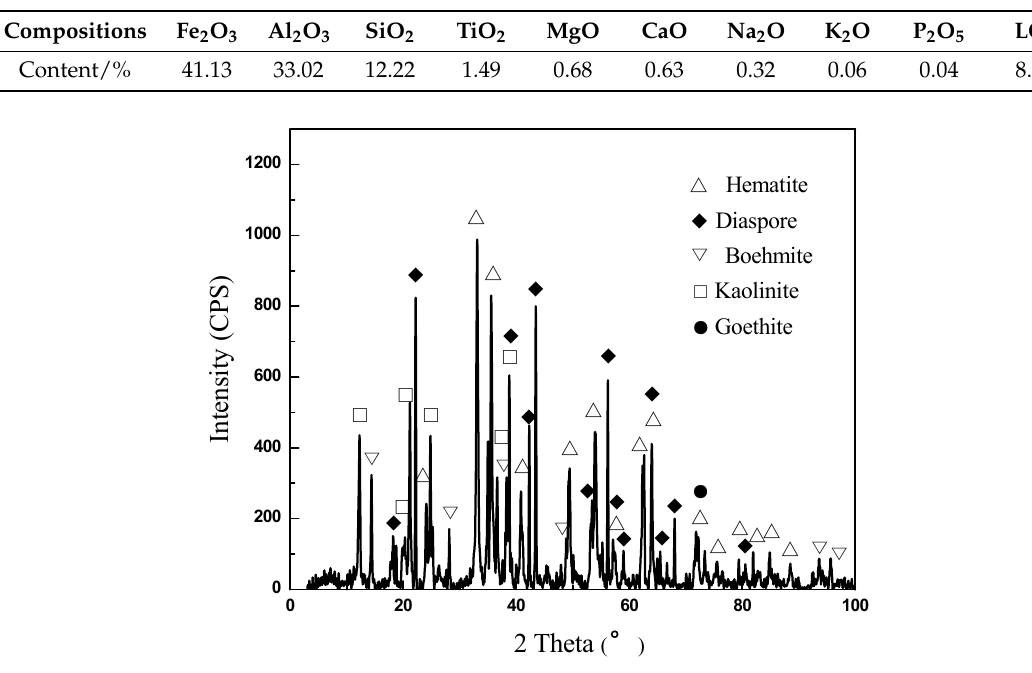
Figure 2. The XRD image of the ferric bauxite adopted.